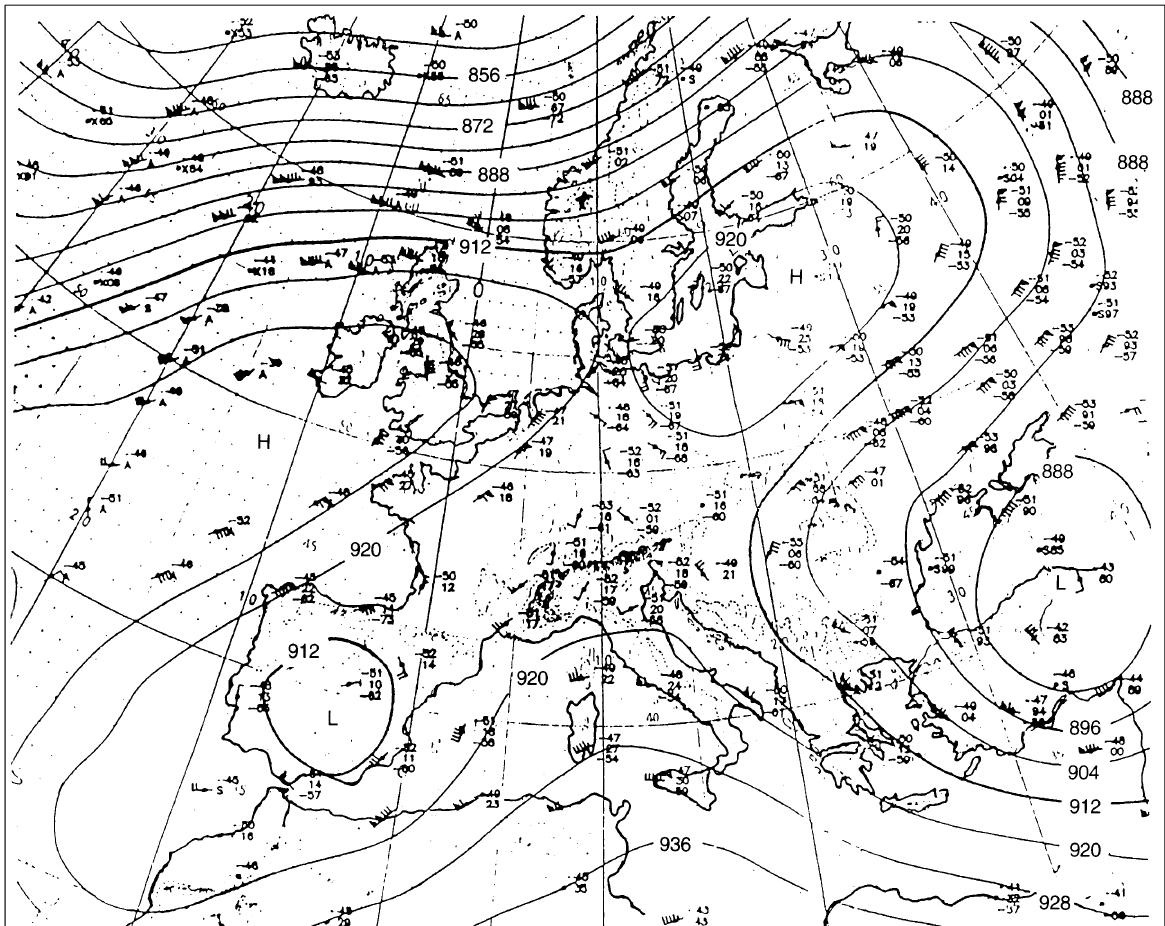
Fig. 2. 24 December 1992; 300-hPa map (Courtesy of European Meteorological Bulletin, Germany)